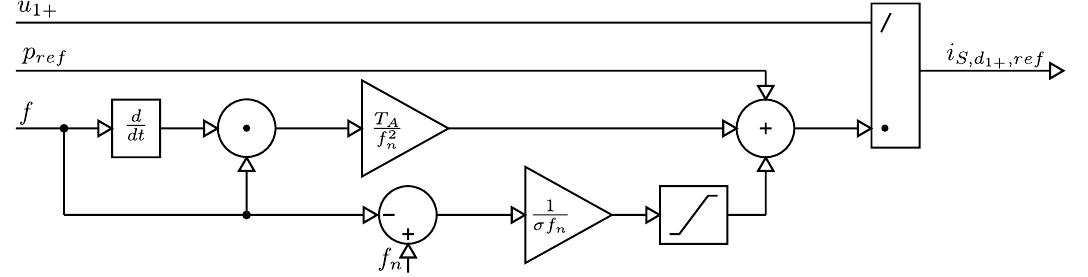
Figure 6. Active power and SI control of Figure